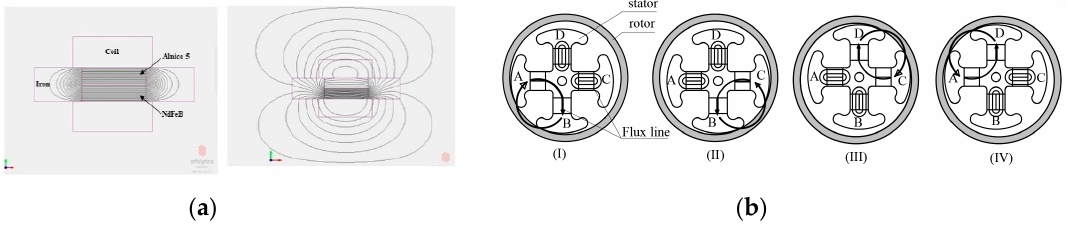
Figure 2. Driving principle of an electropermanet magnet: ( a ) Change in Flux path according to the basic driving principle of the electropermanet magnet; ( b ) Basic operation of the wobble motor using the electropermanet magnet.